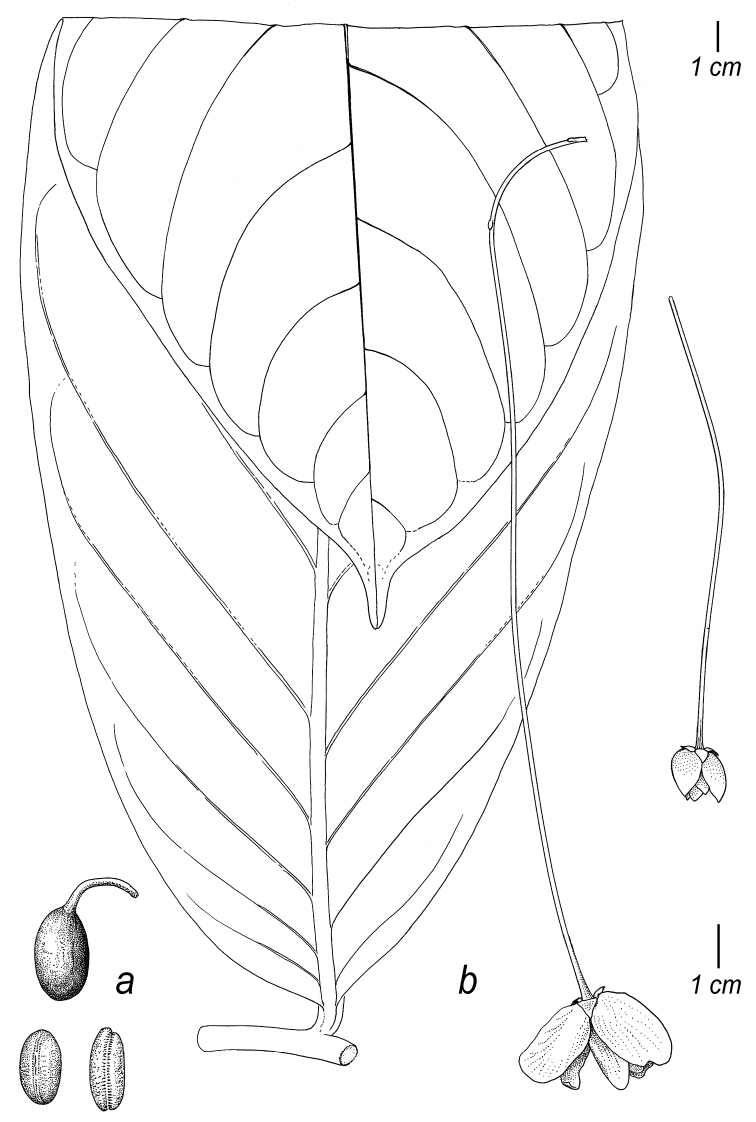
Cremastospermalongipes Pirie. a monocarp (with stipe) and seeds b leaf, flower and flower bud (aFernández 8872bForero et al. 6576).